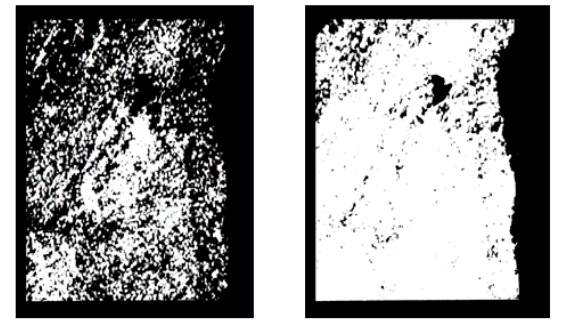
Figure 9 – Number of matched points with DM, T25, Area02: left: threshold 0.9, right: threshold